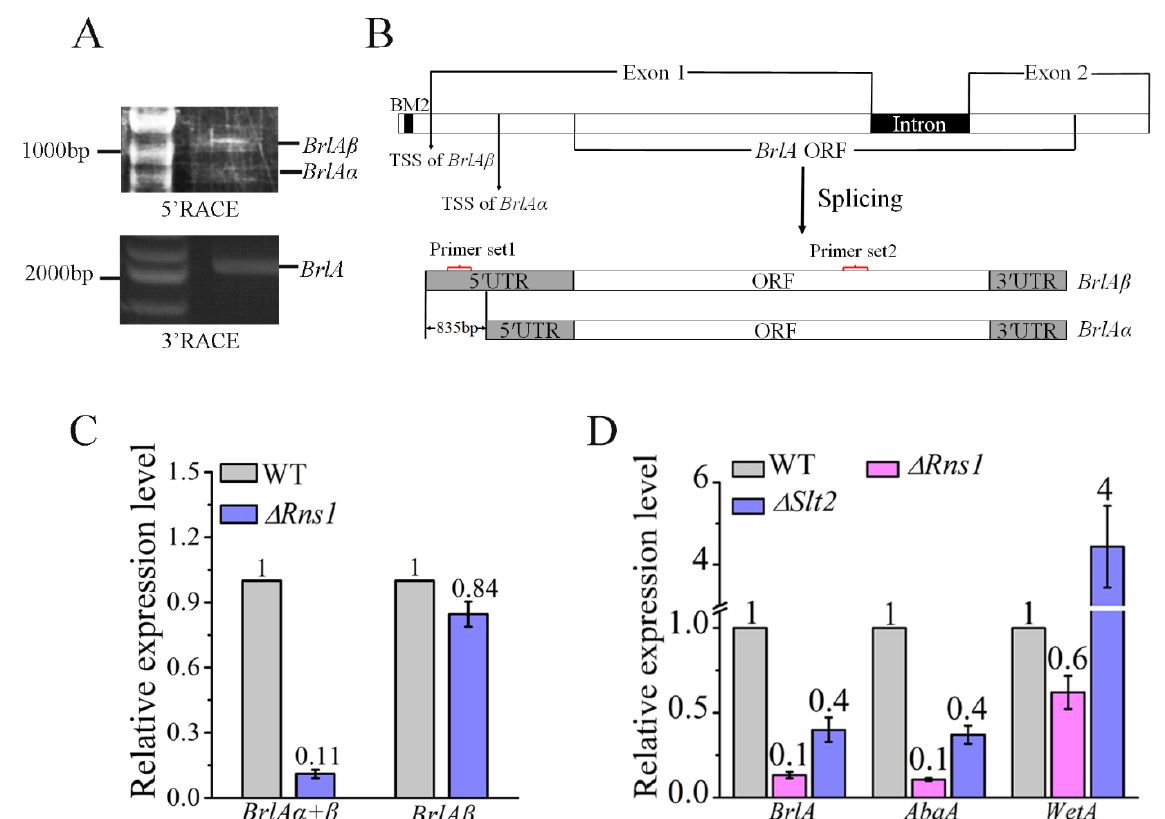
Figure 3. Identification and characterization of the transcripts BrlA α and BrlA β of the BrlA gene. ( A ) 5 (cid:48) RACE (upper panel) and 3 (cid:48) RACE (lower panel) amplification of the BrlA transcripts using the RLM RT-PCR kit. Note: two PCR products were obtained with 5 (cid:48) RACE. ( B ) A diagrammatic representation of the genome sequence of the gene BrlA (upper panel) and its two transcripts ( BrlA α and BrlA β ) (down panel). The position of the BM2 motif is shown. Note: the two transcripts have the same major ORF and different 5 (cid:48) UTR. TSS: transcription start site. ( C ) qRT-PCR analysis of the expression of BrlA β with Primer set 1, and of BrlA α and BrlA β using the Primer set 2 during conidiation. The relative positions of the primers are shown in (B). ( D ) qRT-PCR analysis of the expression level of BrlA (the Primer set 2), AbaA and WetA in WT, the deletion mutants ∆ Rns1 and ∆ Slt2 . The values in each figure represent the fold-changes of expression of a gene in a mutant compared with WT, which is set to